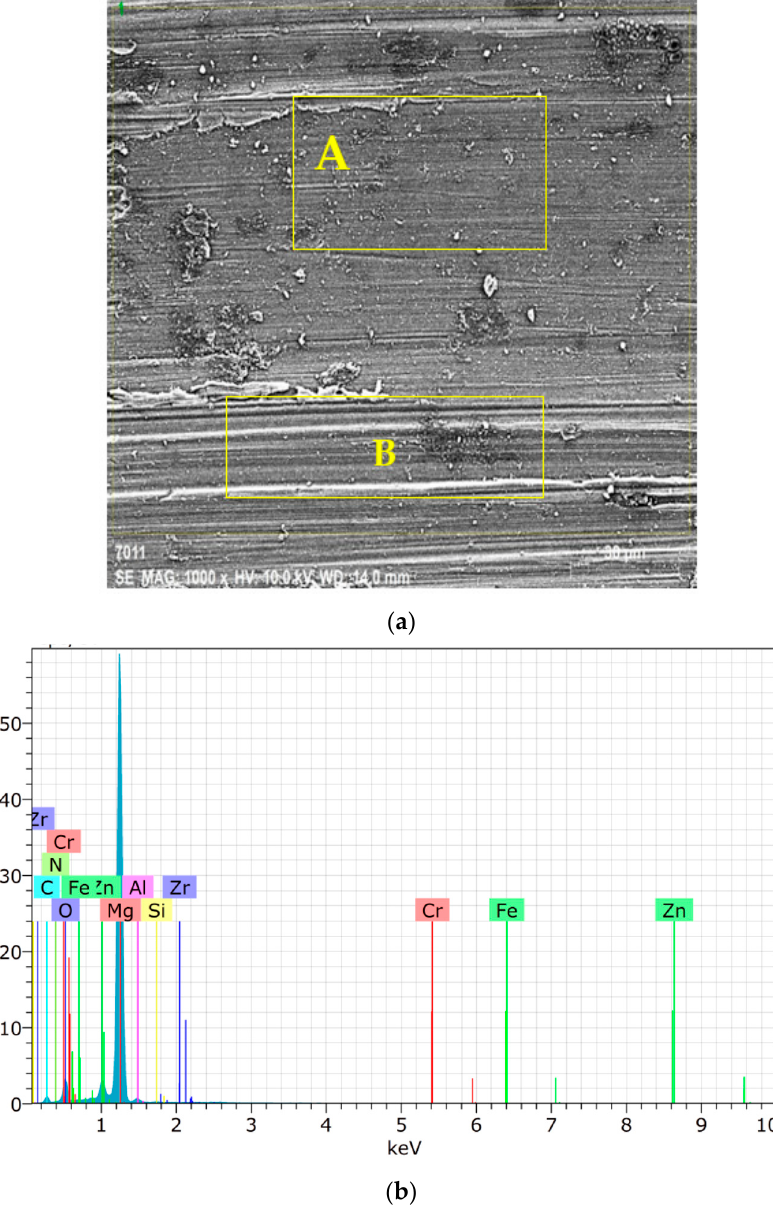
Figure 16. Worn surfaces of the ZK60 SiC15 AIN0.5: ( a ) SEM image at 1k×; ( b ) the elemental spectrum response graph of the ZK60 SiC15 AIN0.5. Table 5. General EDX analyses of the image shown in Figure